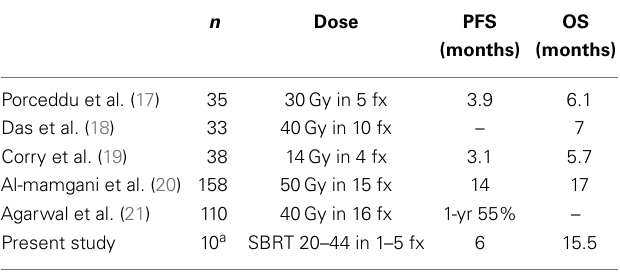
Table 3 | Summary of results for hypofractionated conventional external beam radiotherapy in locally advanced head and neck cancer .